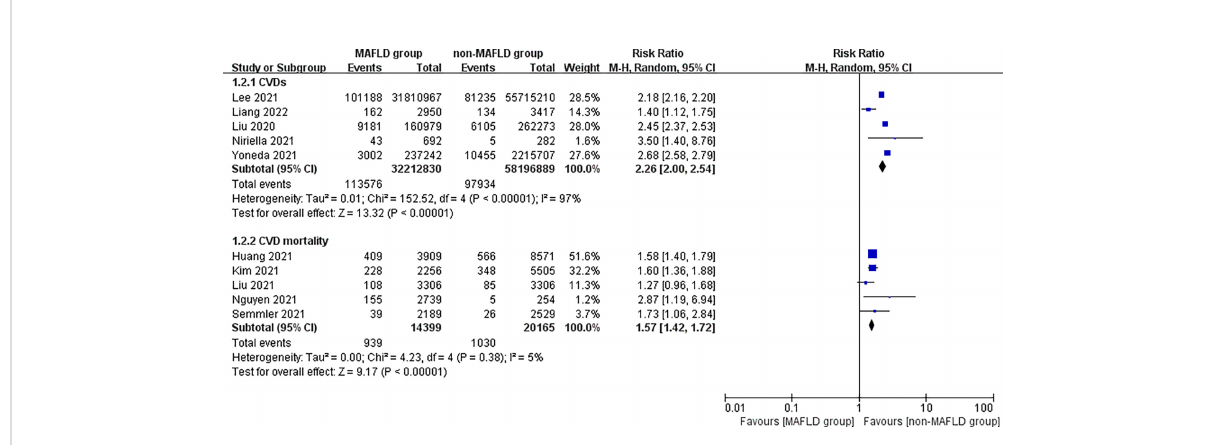
FIGURE 3 Subgroup analysis of CVD incidence and CVD mortality during follow-up between the MAFLD group and the control